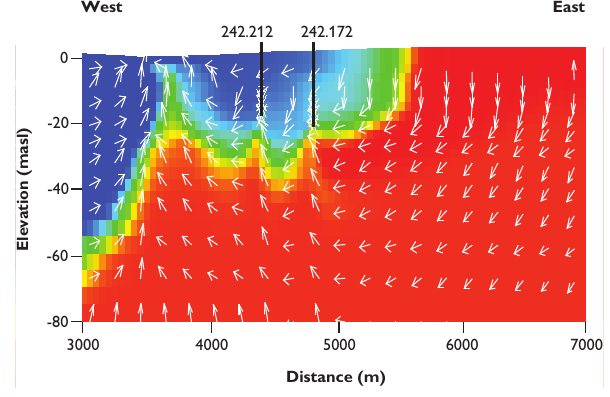
Fig. 14. Flow vectors for scenario 3 in year 2300, model row 62 with two pumping wells. Zoomed in on the eastern freshwater lens. Logarithmic flow vector scale and exaggerate vertical velocity flow vectors are